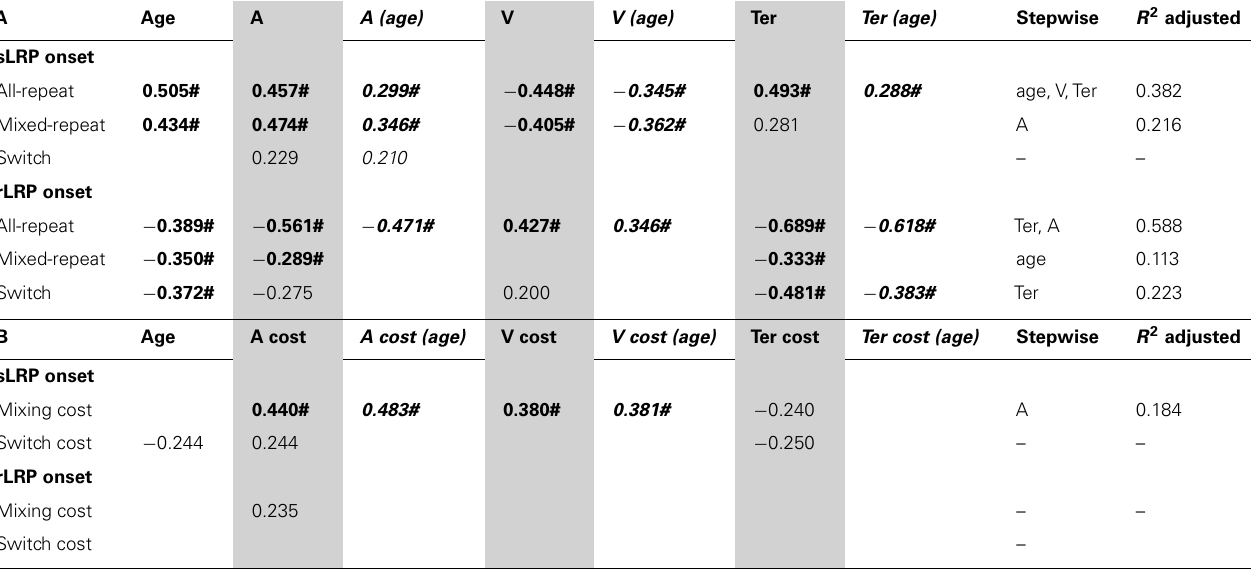
Table 4 | Correlation between onset latency of stimulus-/response-locked LRP and age/model parameters for (A) each trial type and (B) mixing/switch cost on both LRP and model